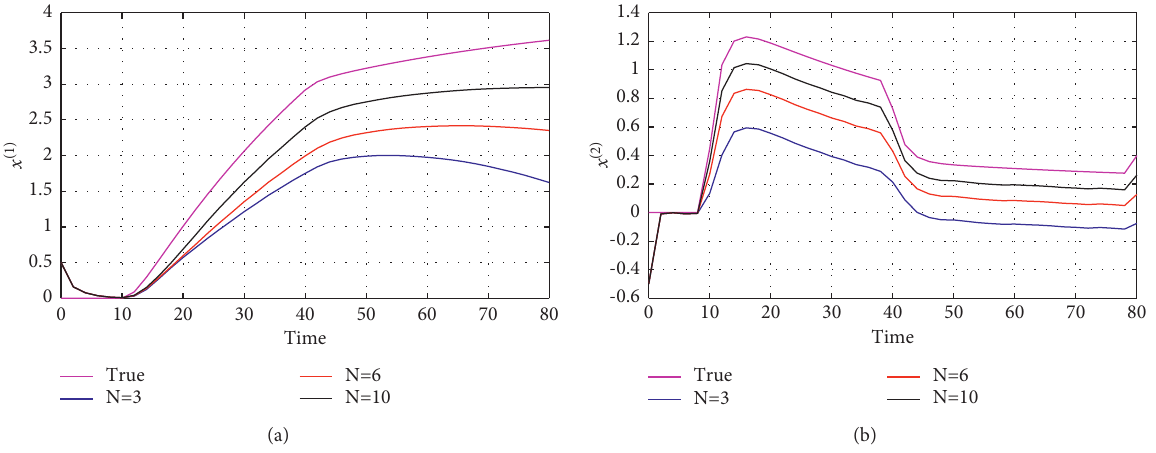
Figure 5: Performance of MHE with N � 3, N � 6, and N � 10 and variable σ w . (a) Estimation of x ( 1 ) . (b) Estimation of x ( 2 ) AD